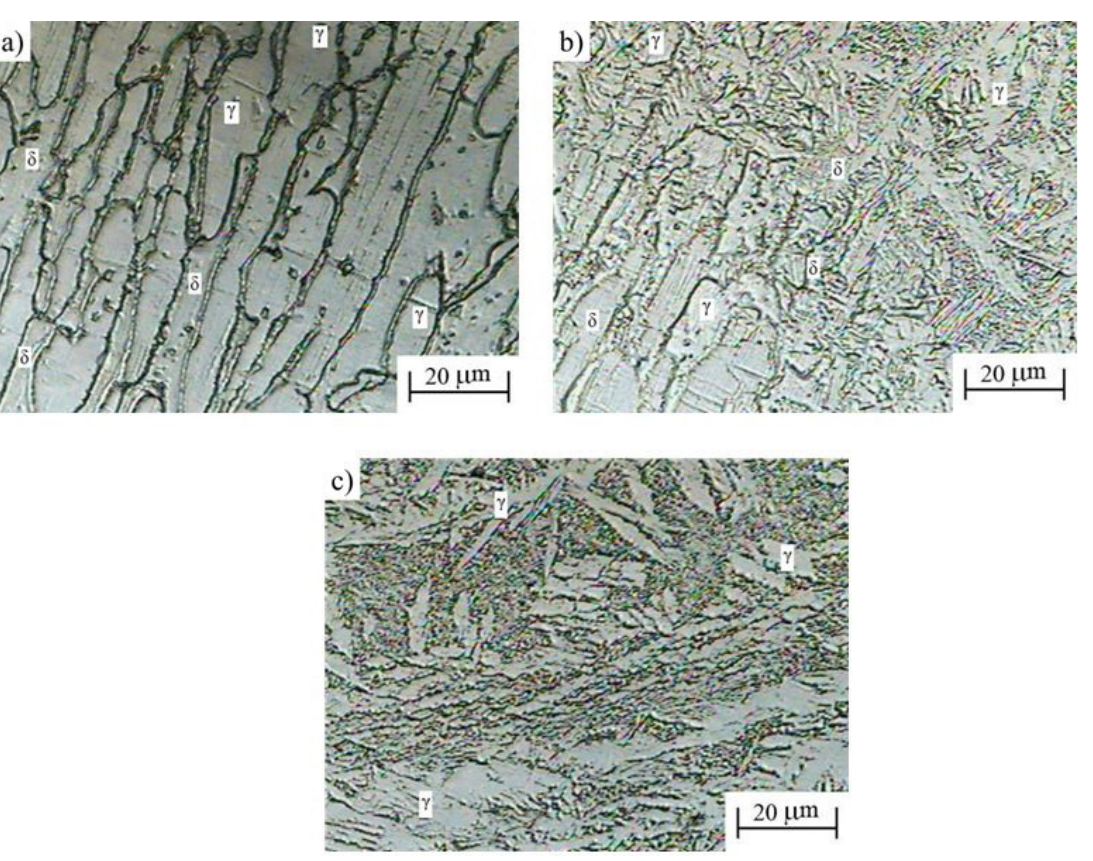
Figure 4. Microstructure of WJ1 treated 60 minutes at 800°C. Images of (a) BM, (b) FL and (c) WMC regions. Reagent: